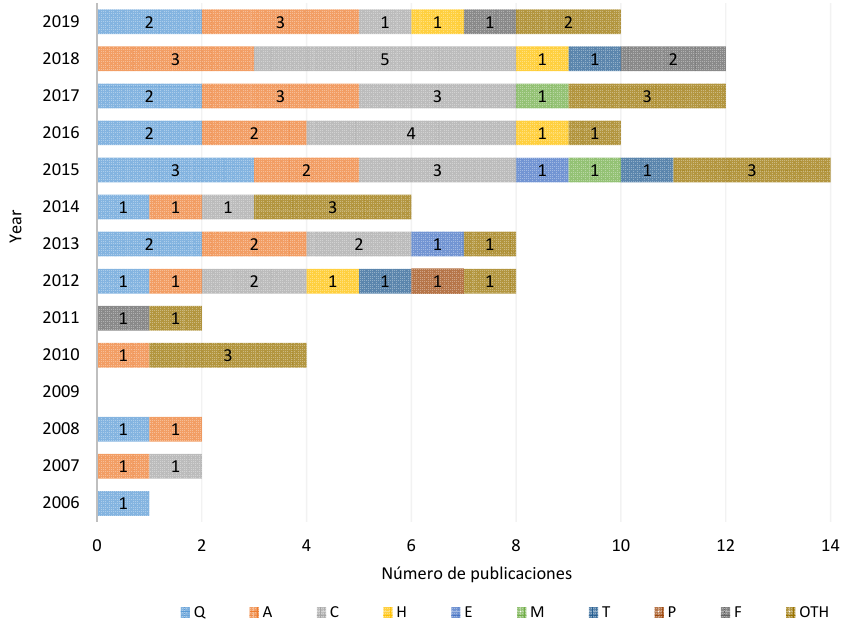
Figure 3. Publications by field and by year.